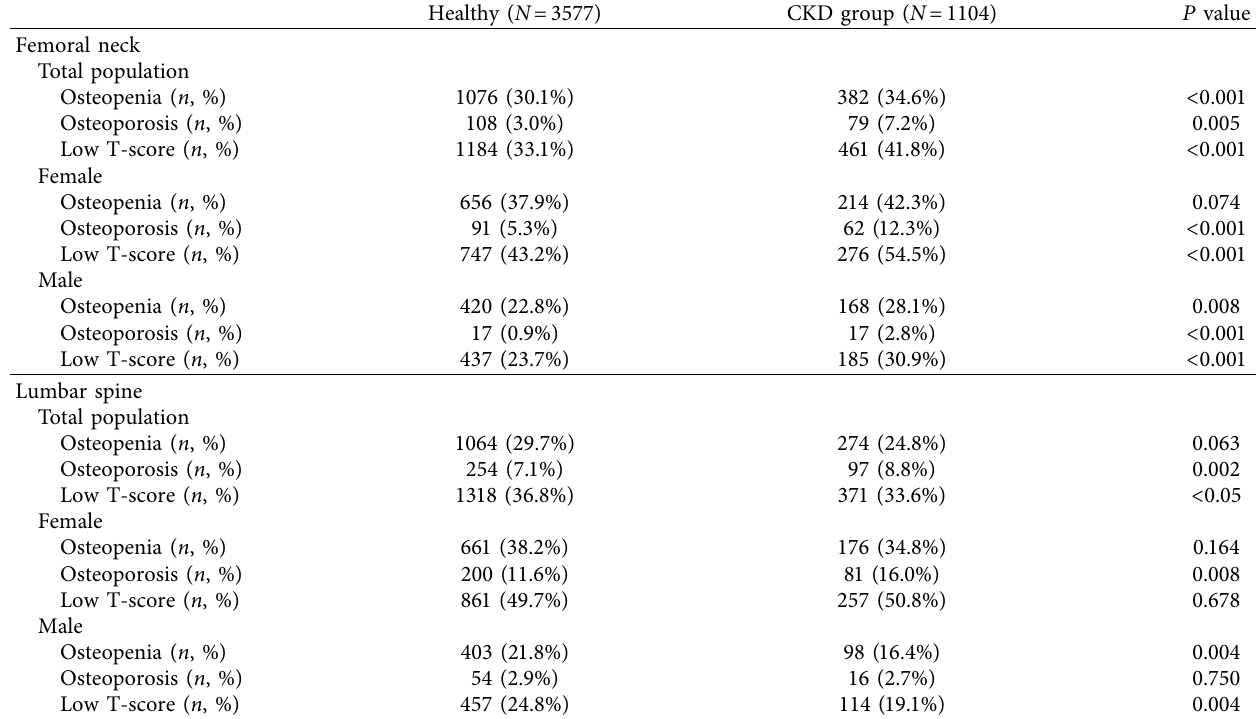
Table 2: Prevalence of osteopenia, osteoporosis, or low t-score in the at-risk population according to the presence of CKD (male participants aged ≥ 50 years and postmenopausal women). Healthy ( N � 3577) CKD group ( N �